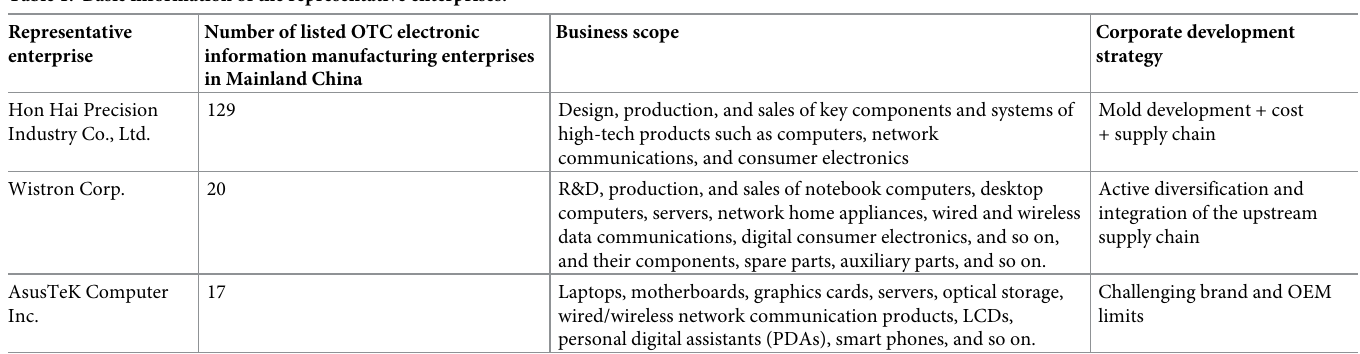
Table 1. Basic information of the representative